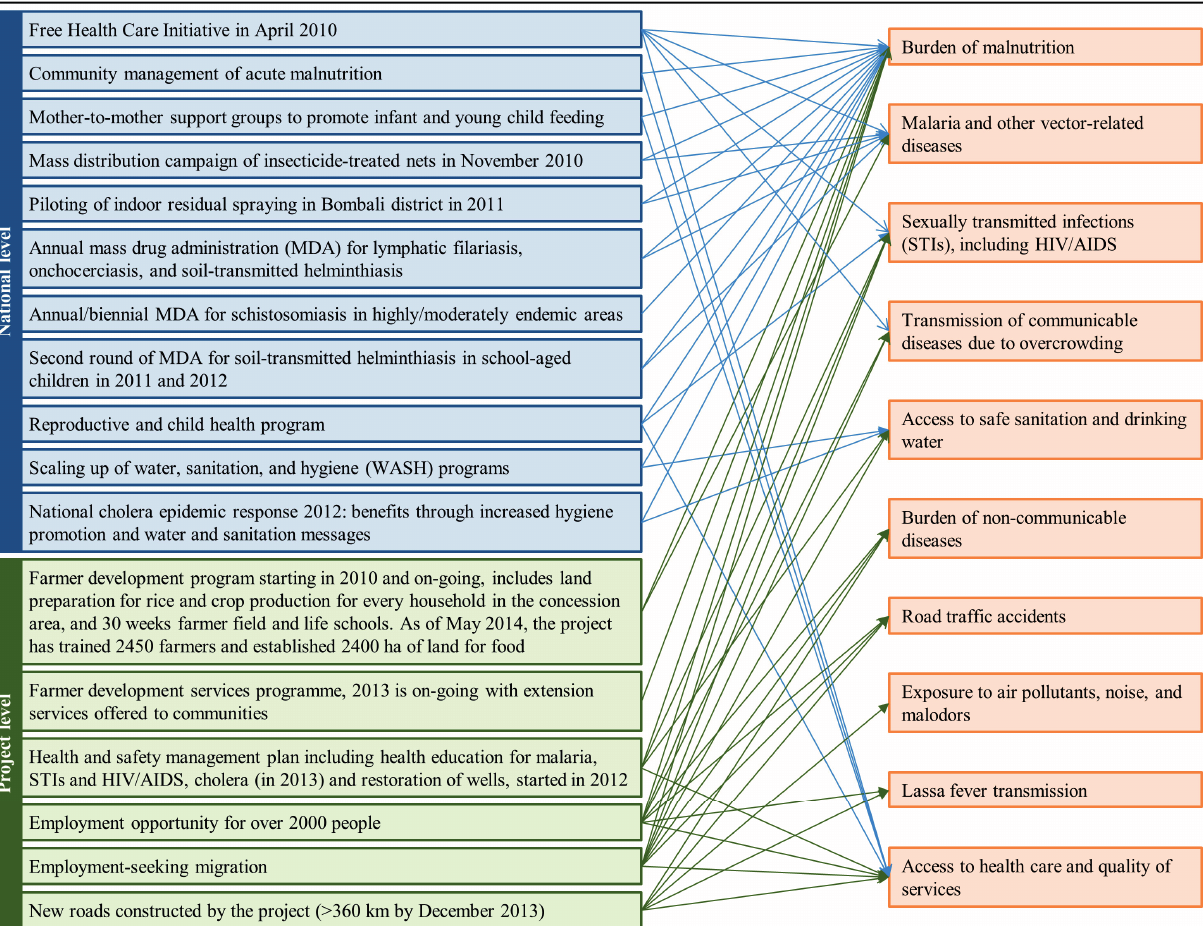
Figure 1. National interventions or programs and interventions initiated by the Addax Bioenergy Sierra Leone (ABSL) project between 2010 and 2013 and the associated health